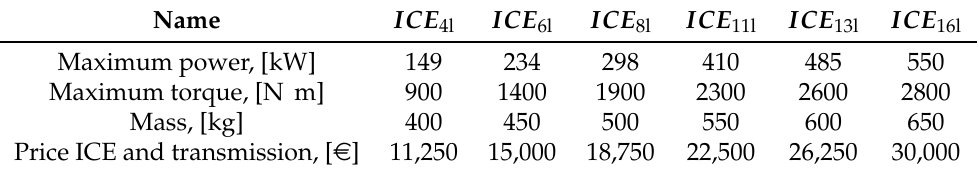
Table A6. ICE data.